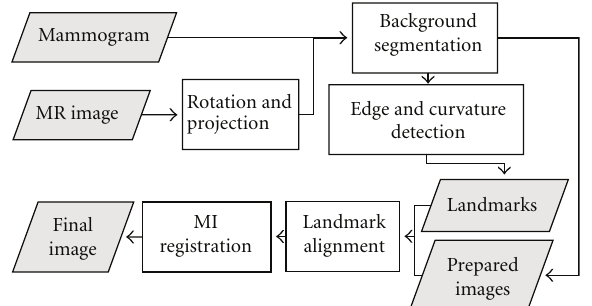
Figure 2: Overview of complete algorithm. Shaded parallelograms represent input/output objects, while rectangles represent process- ing steps.